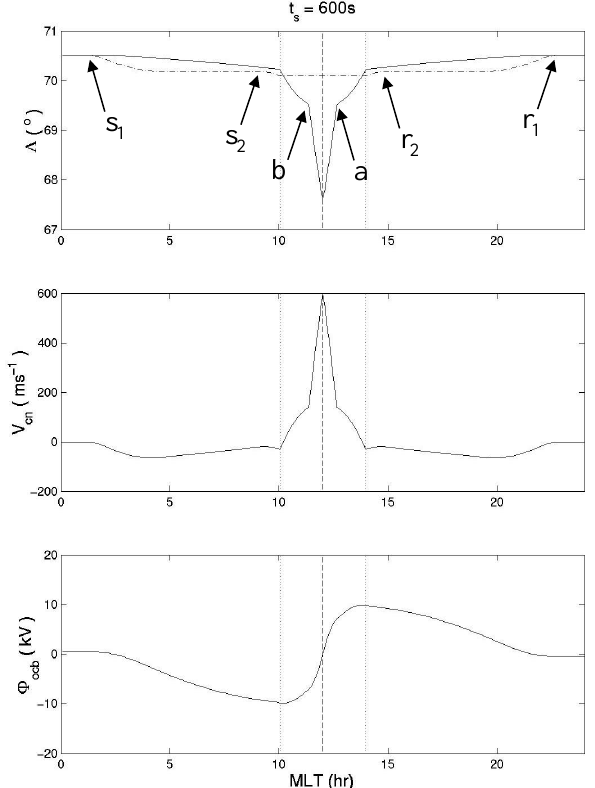
Fig. 4. Model output boundary characteristics corresponding to Fig. 3. The format is the same as Fig. 2. r 1 and s 1 mark the ex- tent of the perturbation to the equilibrium boundary (dash-dot line) caused by the first pulse of reconnection. Similarly, r 2 and s 2 mark the extent of the perturbation to the equilibrium boundary due to the second reconnection pulse. The extent of the active OCB (the active “merging gap”, mapping to the segment of the magnetopause where reconnection is ongoing – solid line) is between the points a and b . The middle and lower panels show the poleward convection velocity at the OCB and the electrostatic potential around the OCB,